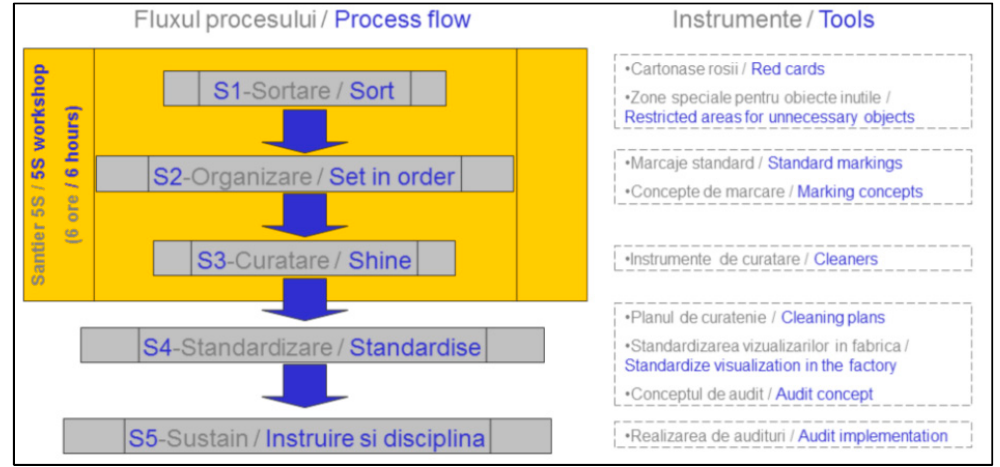
Figure 3. Implementation flow of the 5S method.